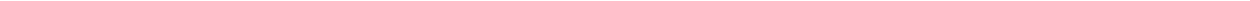
Fig. 1 Parkin interacts with HIF-1 α . a Parkin protein expression was signi fi cantly decreased in breast cancer specimens compared with non-tumor breast tissues as analyzed by IHC. Left panel: representative IHC staining images of Parkin in a human breast TMA. Scale bar: 20 μ m. Right panel: summary of IHC staining of Parkin in breast cancer specimens ( n = 120) and non-tumor breast tissues ( n = 48) in a human breast TMA (TMA-BR2082a; US Biomax). b Parkin mRNA levels were signi fi cantly decreased in human breast cancers compared with matched adjacent non-tumor breast tissues ( n = 113). The data were obtained from TCGA. In a , b , P < 0.001; two-tailed Student ’ s t test. c Low Parkin expression was associated with poor relapse-free survival in breast cancer patients. The data were obtained from Kaplan – Meier plotter. Differences between two survival curves were analyzed using the log-rank (Mantel – Cox) test. d Myc-Parkin interacted with HA-HIF-1 α in MCF7 cells. Cells were co-transduced with HA-HIF-1 α and Myc-Parkin expression vectors for co-IP assays using the anti-Myc (left panels) and anti-HA antibodies (right panels), respectively. e Endogenous Parkin interacted with endogenous HIF- 1 α in MCF7 cells detected by co-IP assays. Endogenous Parkin was knocked down by shRNA in MCF7 cells as a negative control. f The IBR domain of Parkin is required for Parkin to interact with HIF-1 α . MCF7 cells were transduced with vectors expressing WT or different deletion mutants of Myc-Parkin together with the HA-HIF-1 α vector for co-IP assays. g The ID domain of HIF-1 α is required for HIF-1 α to interact with Parkin. MCF7 cells were transduced with vectors expressing WT or different deletion mutants of HA-HIF-1 α vectors together with the Myc-Parkin vector for co-IP assays. h The interaction between Parkin and HIF-1 α analyzed by in vitro GST (left) and His (right) pull-down assays, respectively, using puri fi ed GST-Parkin and His-Trx-HIF-1 α